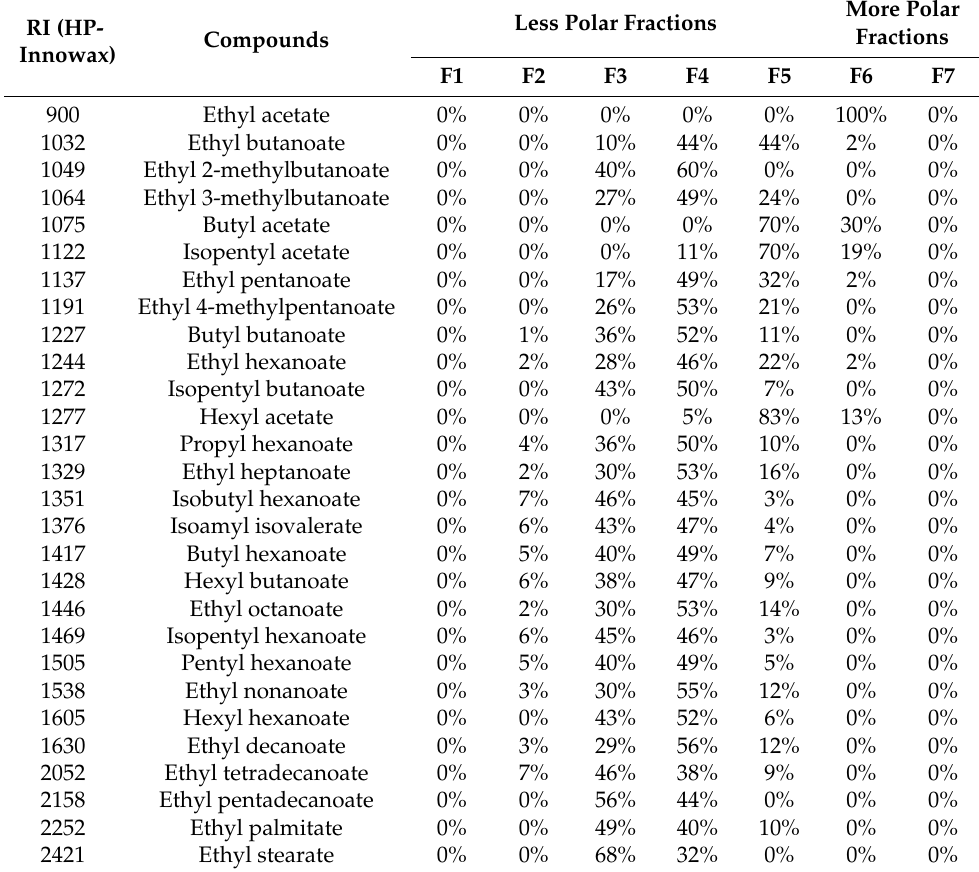
Table 2. Ester distribution (as a percent of the total amount) in different